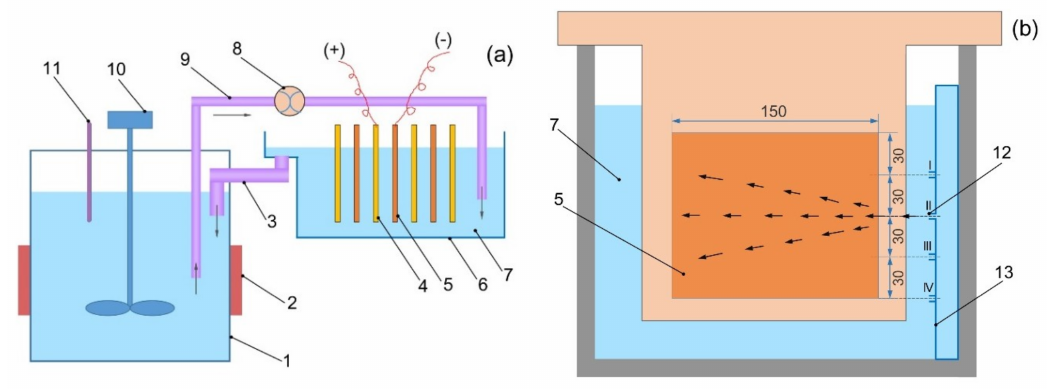
Figure 1. Schematic diagram of the experimental apparatus for copper electrorefining in ( a ) conventional bottom-inlet/top-outlet mode and ( b ) single-side jet inlet mode. 1, plastic barrel;